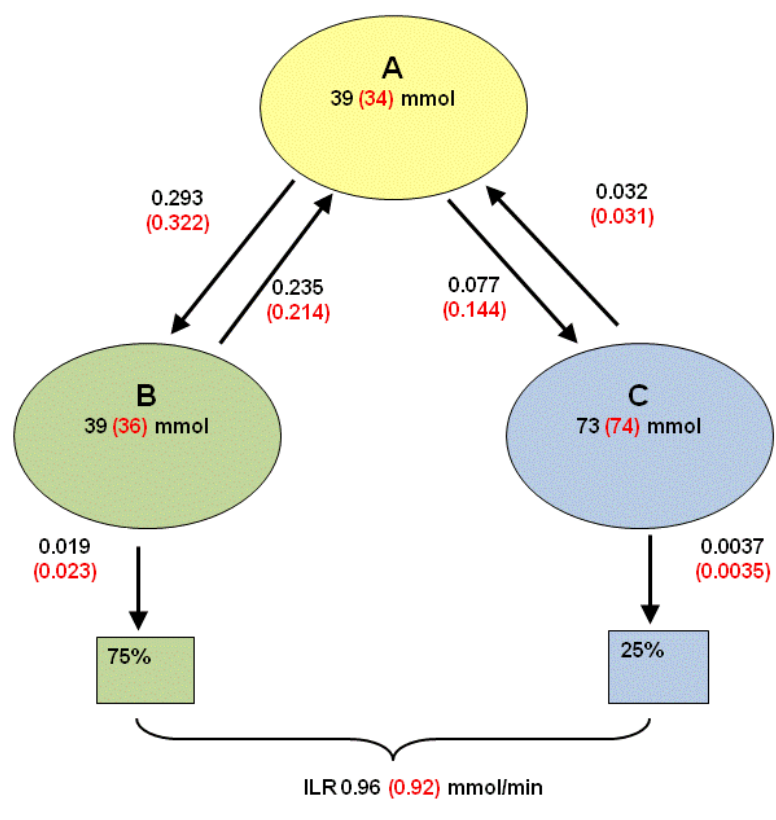
Figure 2. Three compartment model to describe transfers from a primary pool ( A ) to either a readily accessible ( B ) or less-readily accessible ( C ) pool. Values obtained from 14 volunteers with each measured on just one occasion in the overnight fasted state. Subjects were injected intravenously with a bolus dose of [U- 13 C]glucose and blood samples taken at intervals over 150 min. A three compartment model was fitted to the TTR of plasma glucose. Values in parentheses include all volunteers, other values exclude two volunteers for whom inadequate model fits were obtained. Values beside arrows are fractional rate constants (min −1